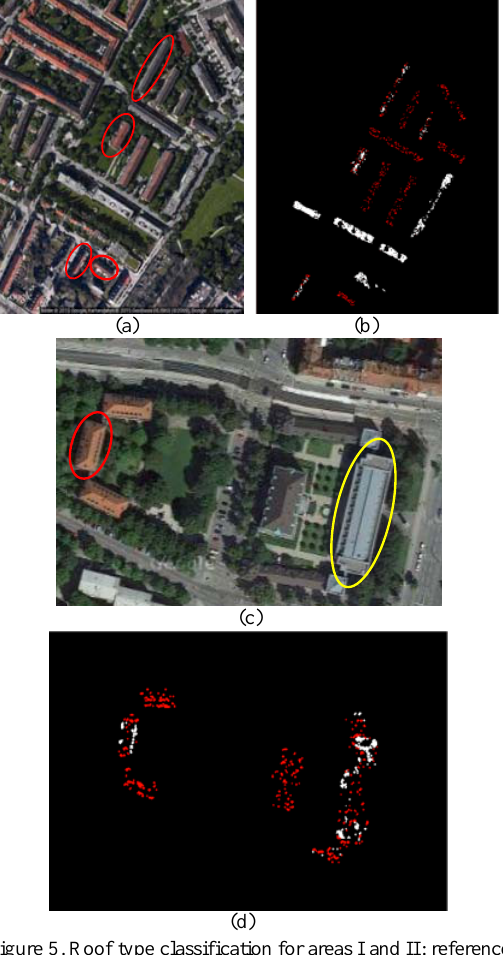
Figure 5. Roof type classification for areas I and II: reference images (a),(c) from © Google Maps and the classification results